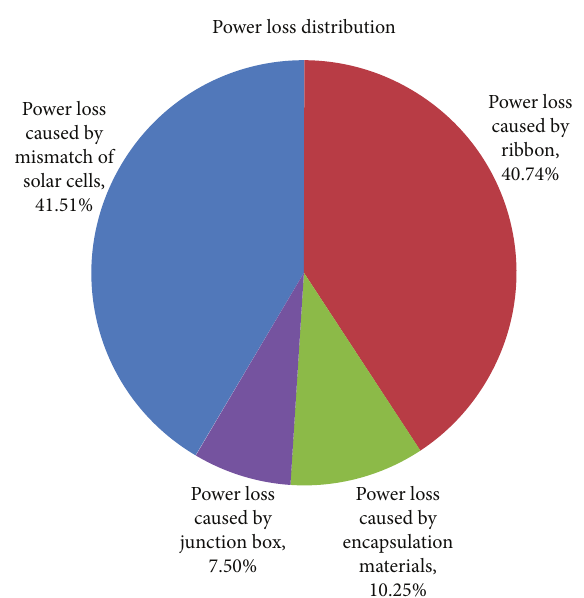
Figure 3: Distribution of the power loss for solar